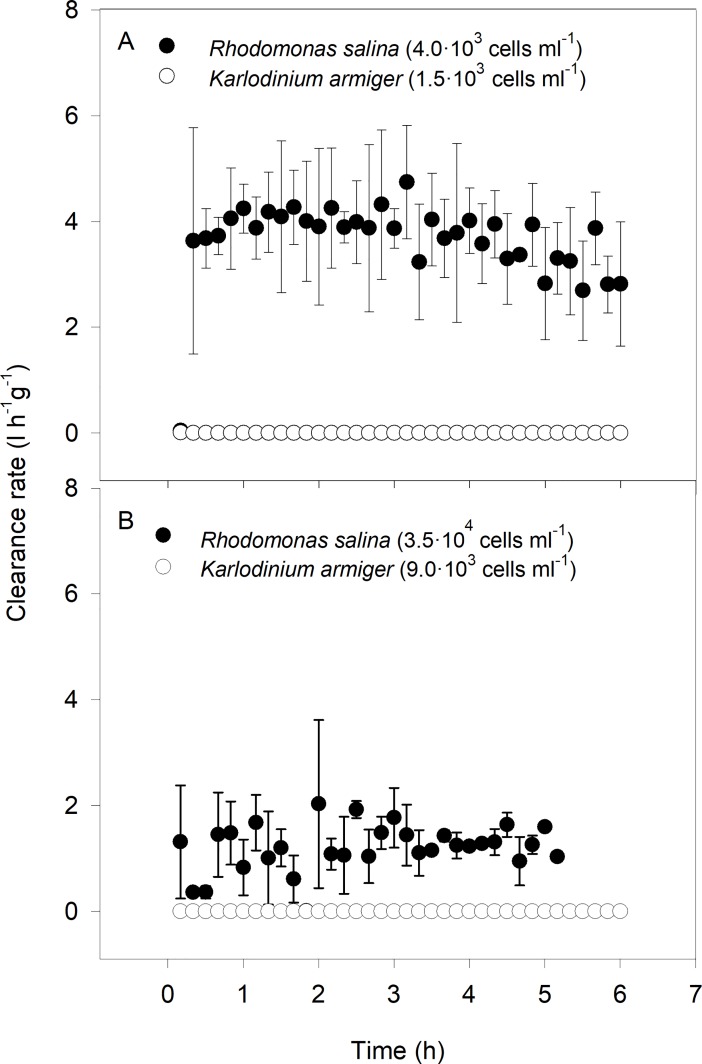
Clearance rate of Mytilus edulis exposed to Karlodinium armiger and Rhodomonas salina.The mussels were exposed to a low and high bio-volume equivalent concentration of each algal species. Data presented as mean values with SE bars.